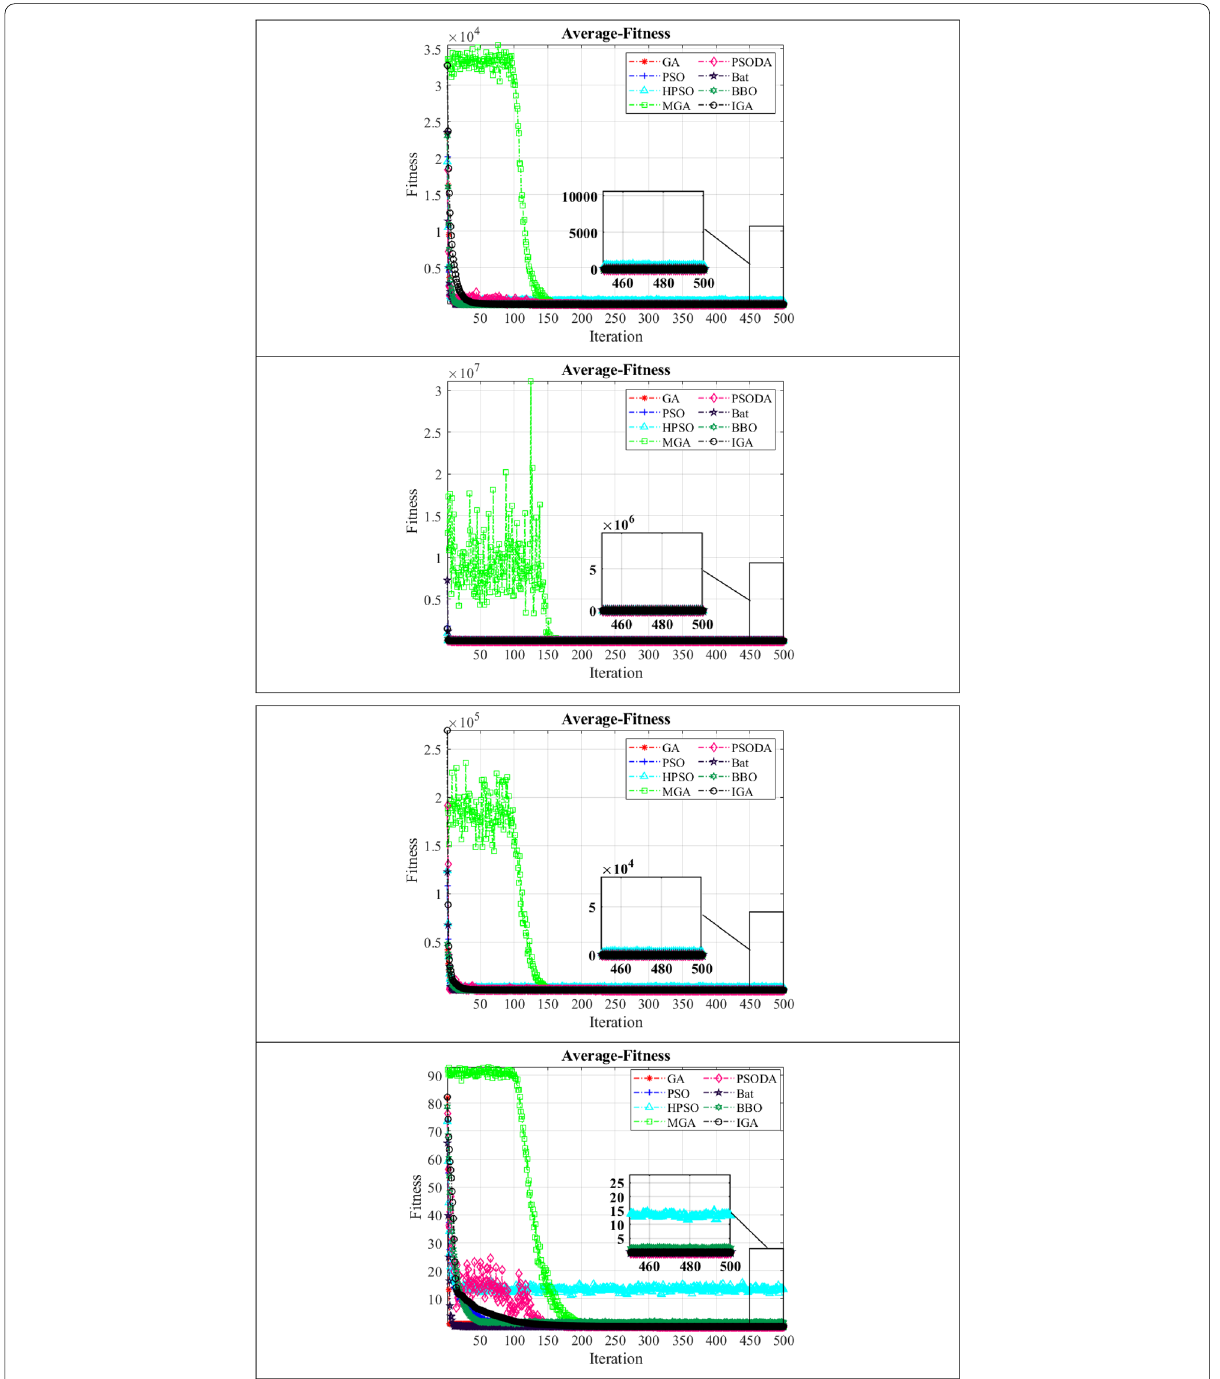
Fig. 9 The average fitness of different compared